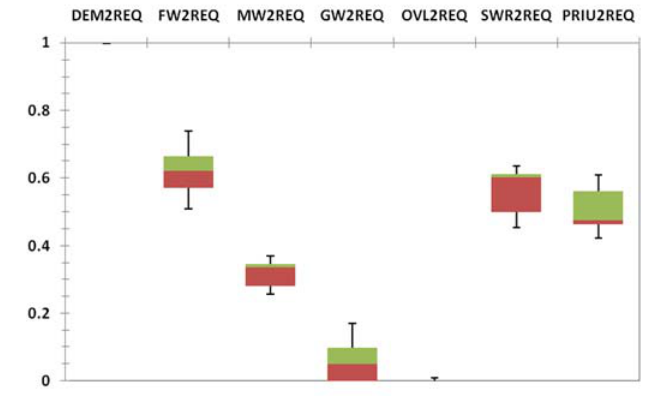
Figure 7. Examples of PIs from the GSTMM model (box plot depicted for each indicator) as dimensionless ratio between the given volume and the total demand required. DEM2REQ is total satisfied water demand; FW2REQ is fresh water; GW2REQ is recycled gray water; MW2REQ is rainwater water; OVL2REQ is overflow rainwater from rain water tank; SWR2REQ is water delivered to sewer; PRIU2REQ is the ratio of the potential demand of recycled